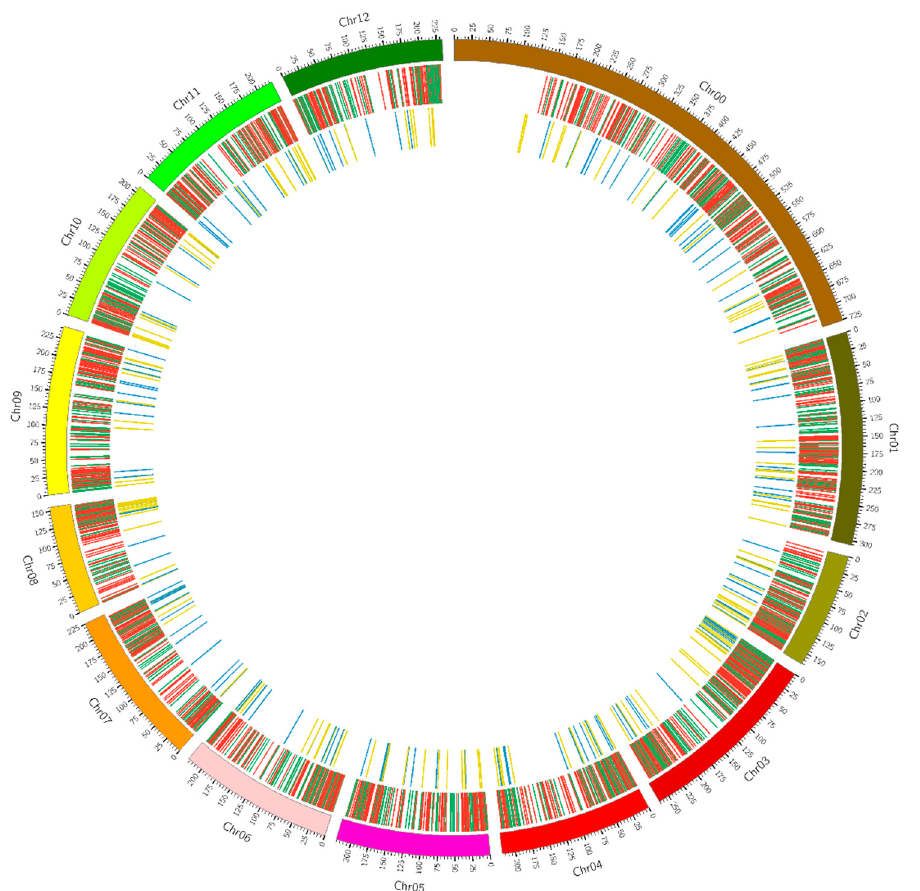
Figure 4 Distribution of the expression of lncRNAs and mRNAs on the different chromosomes. Figure 4. Distribution of the expression of lncRNAs and mRNAs on the different